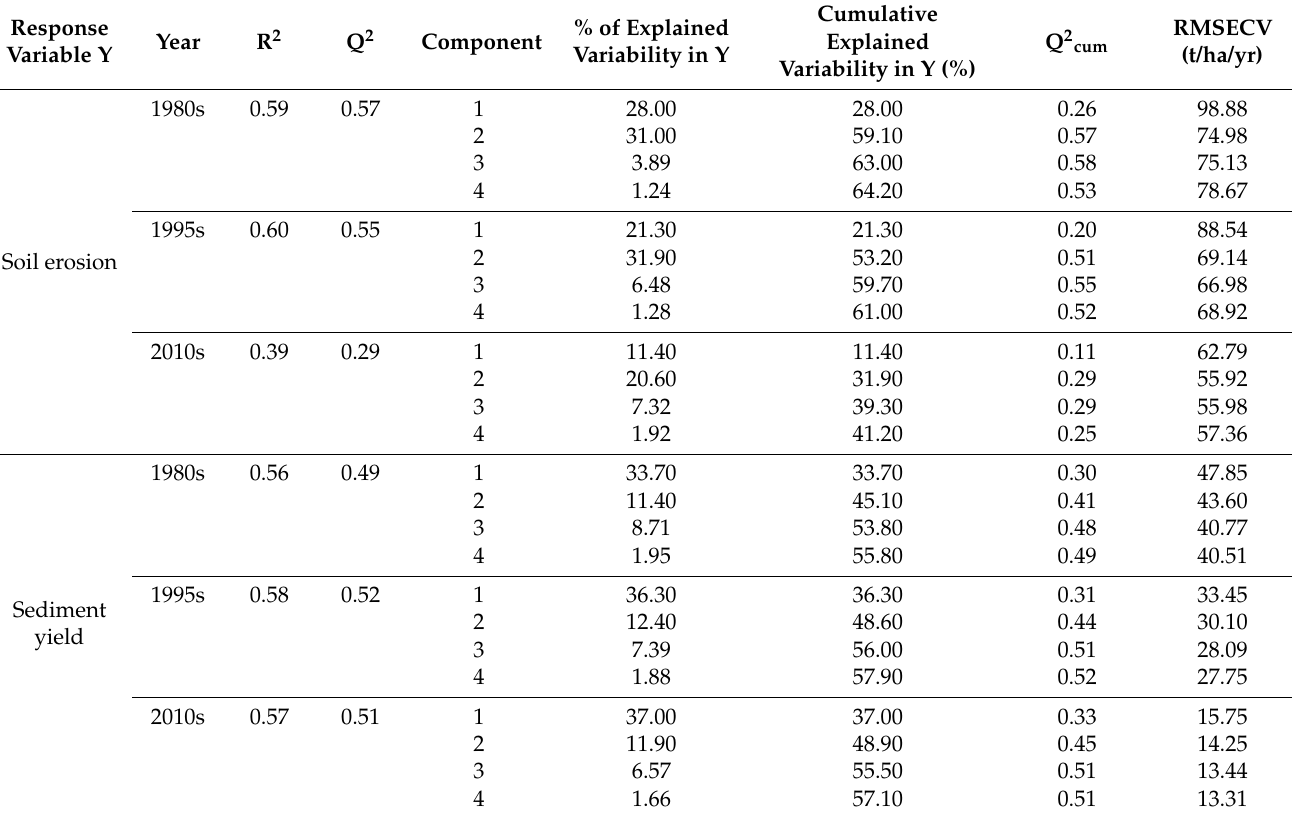
Table 7. Summary of the PLSR models of soil erosion and sediment yield under Combination 4.